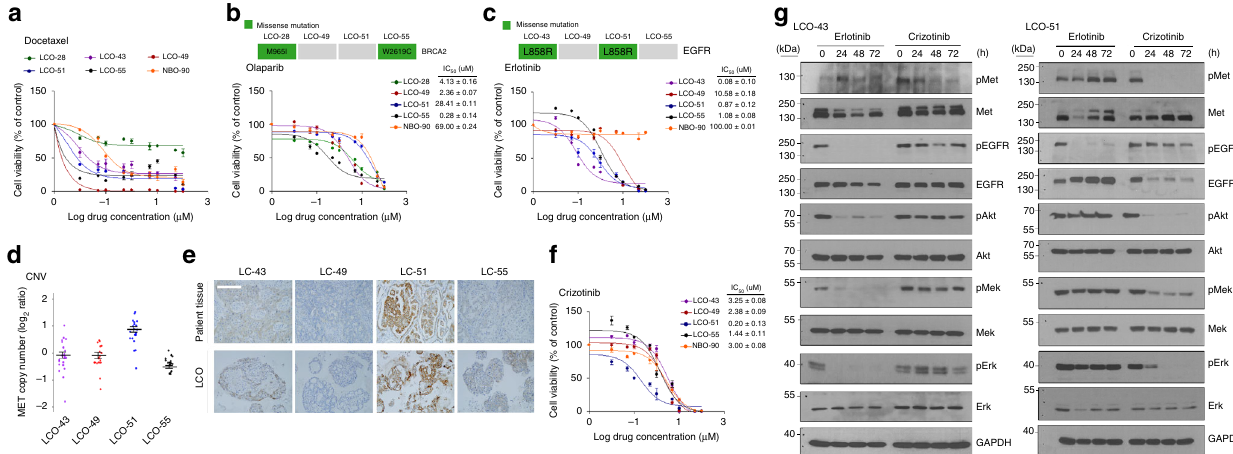
Fig. 6 LCOs as a platform for predicting therapeutic responses. a Dose-response curves after 6 days of treatment with docetaxel. The cell viability was measured by luminescence signal intensities. b and c Dose-response curves after 6 days of treatment with olaparib b or erlotinib c . The indicated drug concentrations were used to treat two LCO lines with mutations (green box), another two LCO lines without mutations (grey box) and the NBO. Representative viability curves were generated from luminescence signal intensities. d The copy number variation (CNV) graph showing MET copy number ampli fi cation in the four LCO lines. e IHC-stained images showing c-MET expression in the four patient tissues and LCOs. Scale bar, 100 μ m. f Dose- response curves after treatment with indicated drug concentrations of crizotinib in four LCOs and a NBO. Representative viability curves were generated from the luminescence signal intensities. g Immunoblot analysis showing changed protein expressions mediating EGFR signalling and c-Met signalling transduction after treating erlotinib and crizotinib. Two LCOs, LCO-43 and LCO-51 were treated with 1 μ M erlotinib and 1 μ M crizotinib for 24, 48 and 72 h. GAPDH was used as a loading control. Full-length blot is shown in the supplementary information, and the gels have been run under the same experimental conditions. All error bars in a – c and f indicate SEM, n = 3. In b , c and f IC 50 values are the average ± SD of each condition analysed in triplicate. When error bars are not visible they are smaller than the size of the